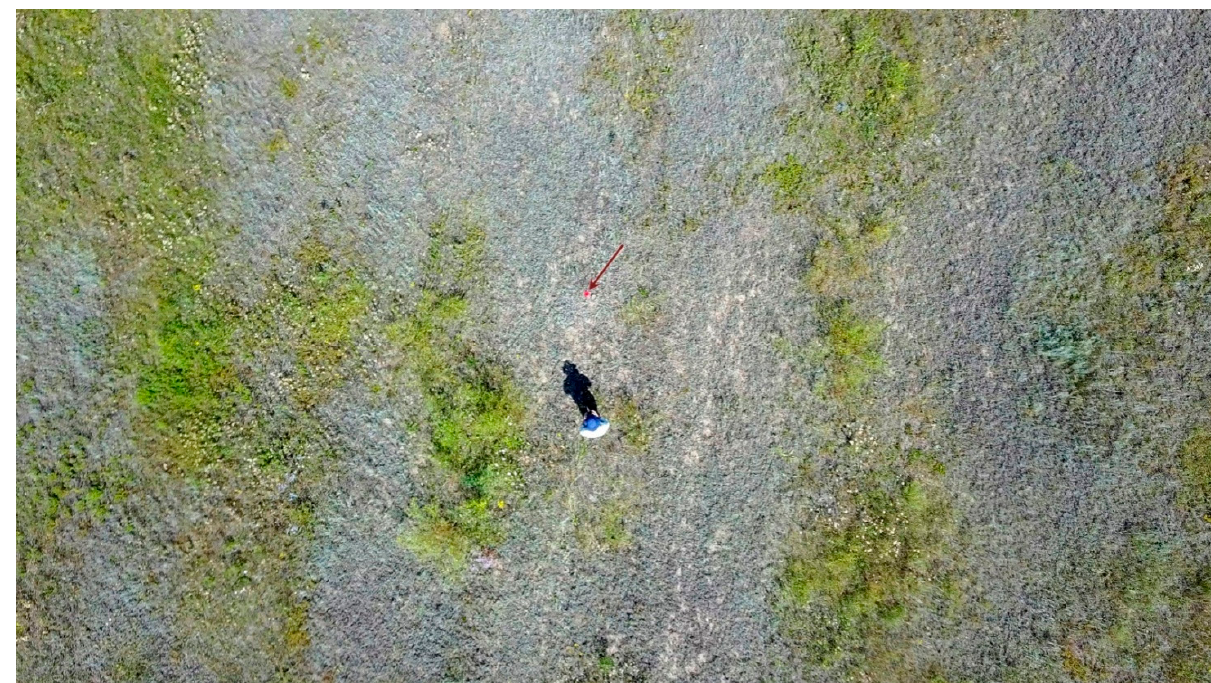
Figure 2. Typical heterogeneous steppe habitat of the Italian locust with vegetation mosaic (grey—short sagebrushes, green—grasses or forbs) in the Kulunda steppe (near Aleksandrovskij settlement): red dot—exact position of an adult (31 July 2019).